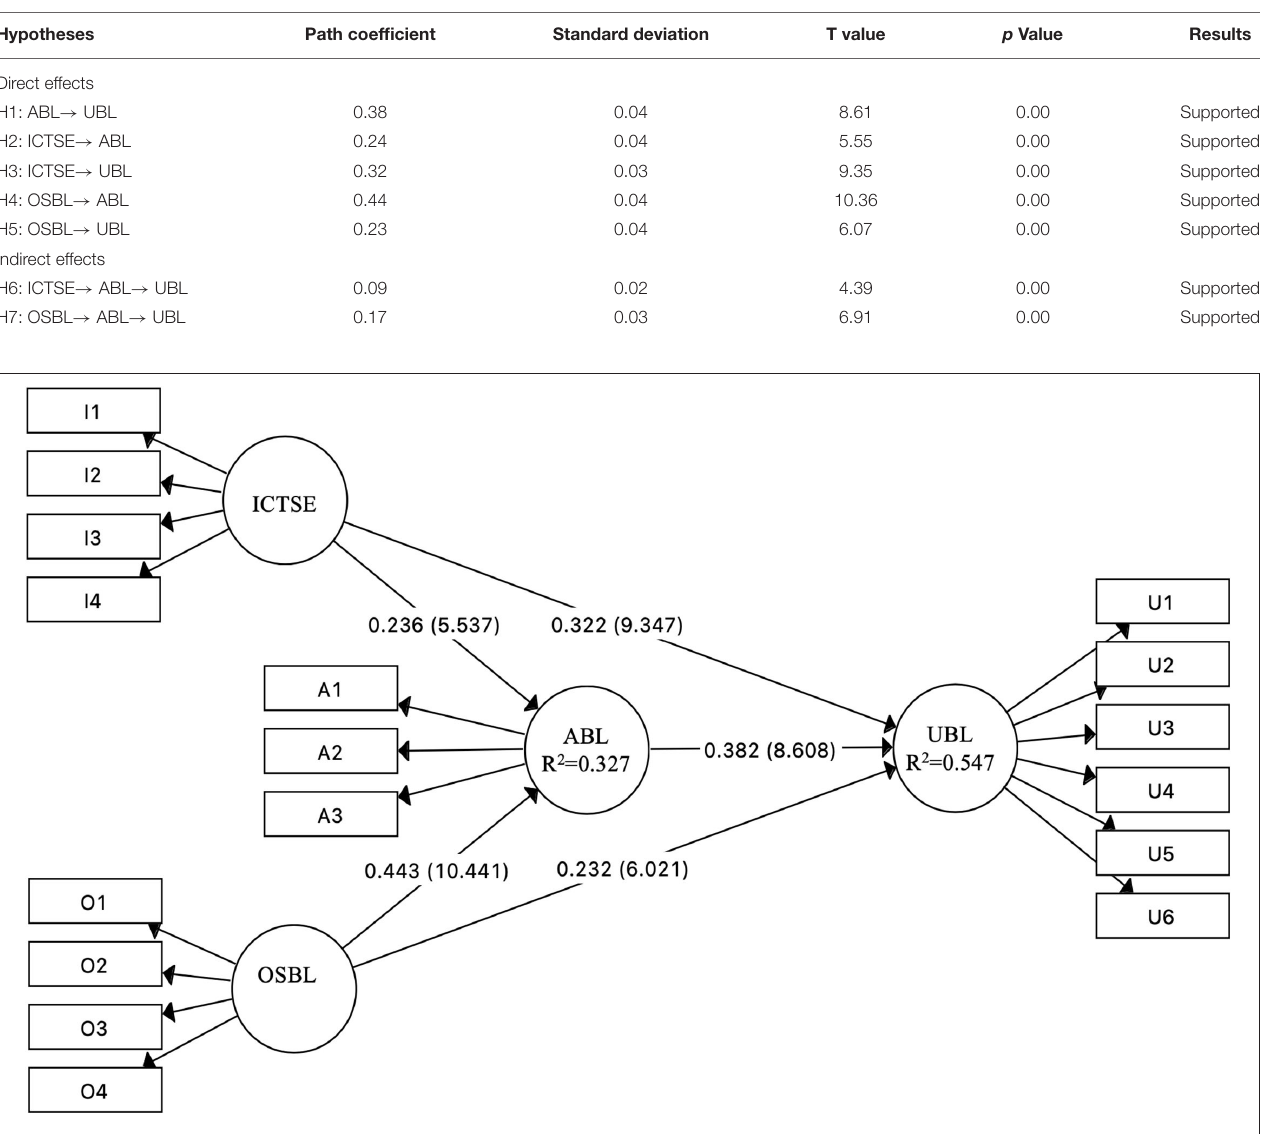
FIGURE 2 | PLS-SEM for predicting the use of blended learning (the values in parentheses are T